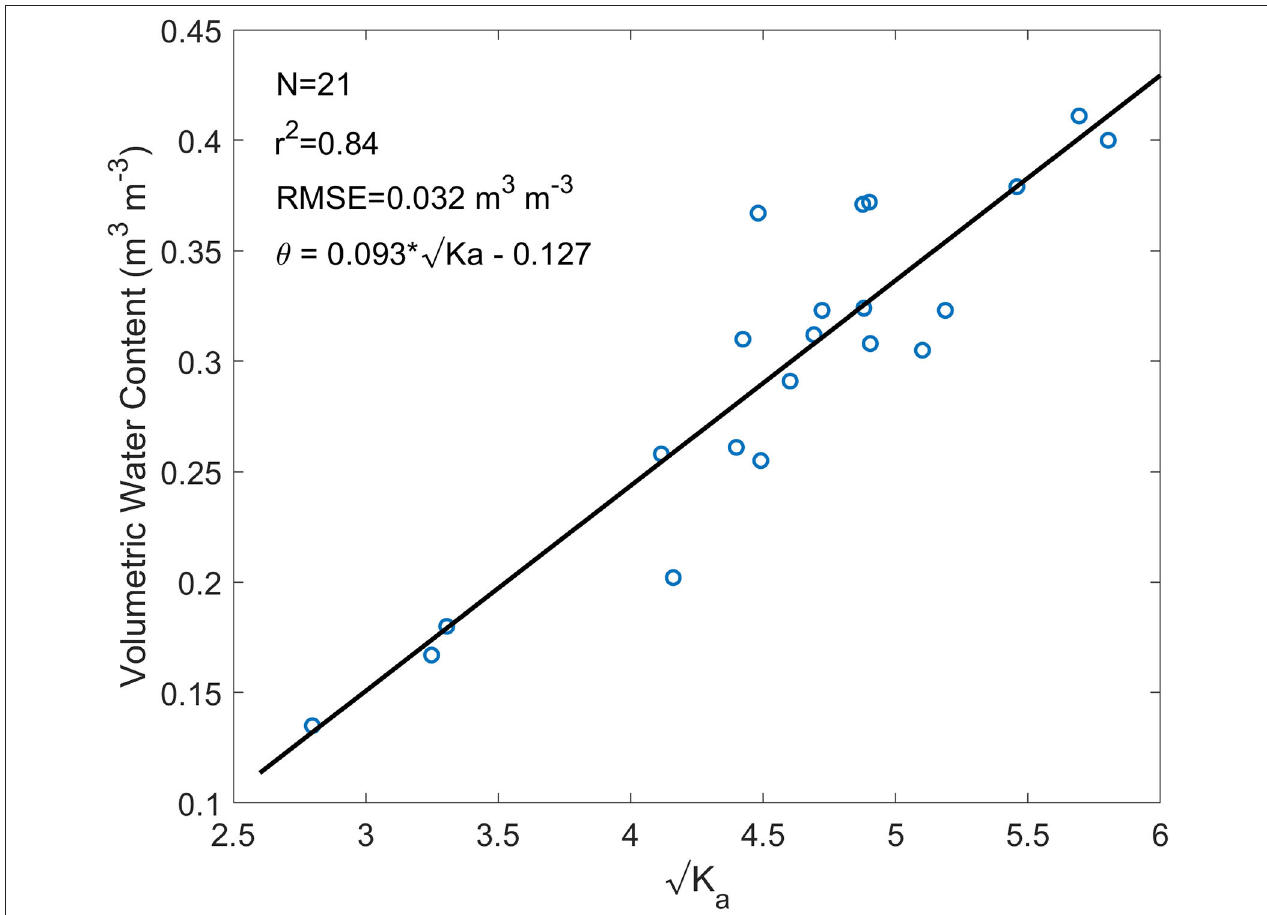
FIGURE 3 | Site-specific calibration of volumetric water content for the 0–12cm soil layer as measured by soil sampling vs. the square root of the apparent dielectric permittivity (K a ) as measured by the portable soil water